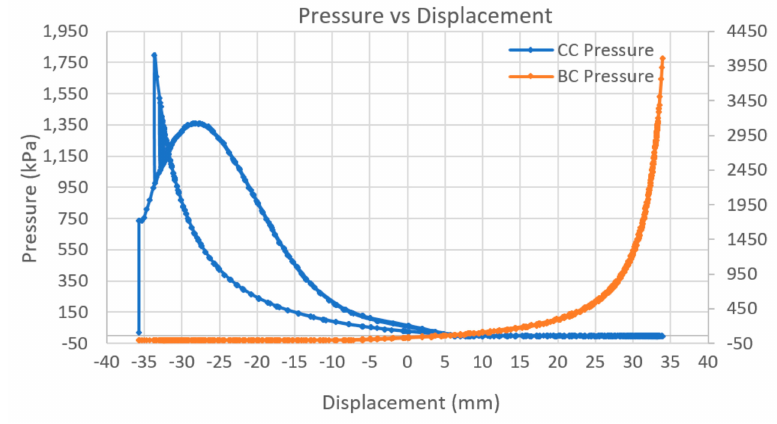
Figure 7. No-load operation: pressure vs. displacement profile for CF = 0.50. 5. Operation with Electrical Load and Different Fixed Combustion Factors (CFs) With electrical load connected, and root-mean-square (rms) current of about 8 amps generated by the FPLG, pressure vs. displacement curves for both CC and BC were obtained from the Simulink program as shown in Figures 8–10. The graphs represent combustion factor values of 0.5, 1 and 2, respectively. As can be observed in the simulation graphs, the system was very sensitive to changes in parameters.